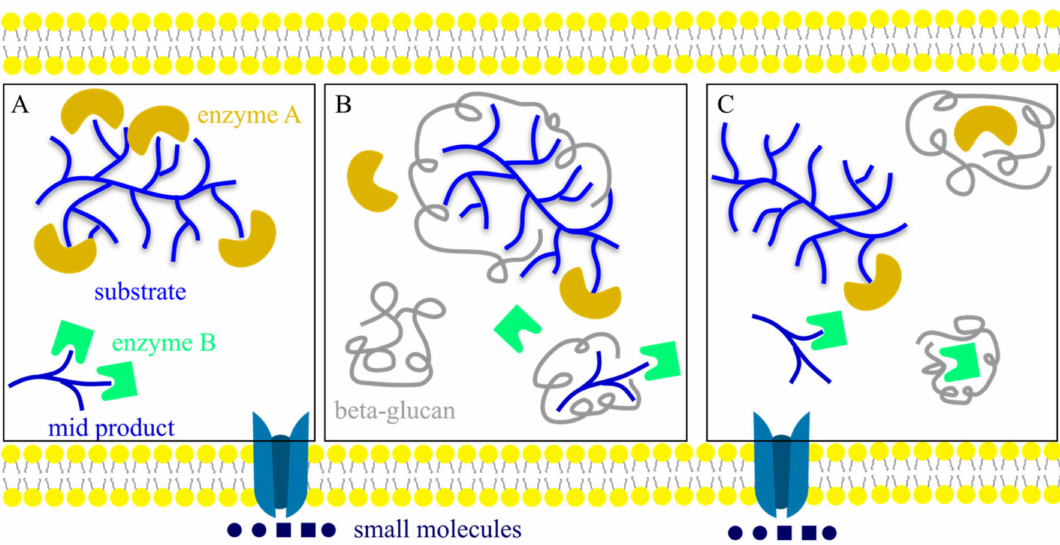
Figure 4. The proposed mechanism of enzyme inhibition. ( A ) The normal enzyme–substrate in- teractions during digestion. ( B ) β -glucans play as a physical barrier to inhibit enzyme–substrate interactions. ( C ) β -glucans bind to enzymes to inhibit enzyme–substrate